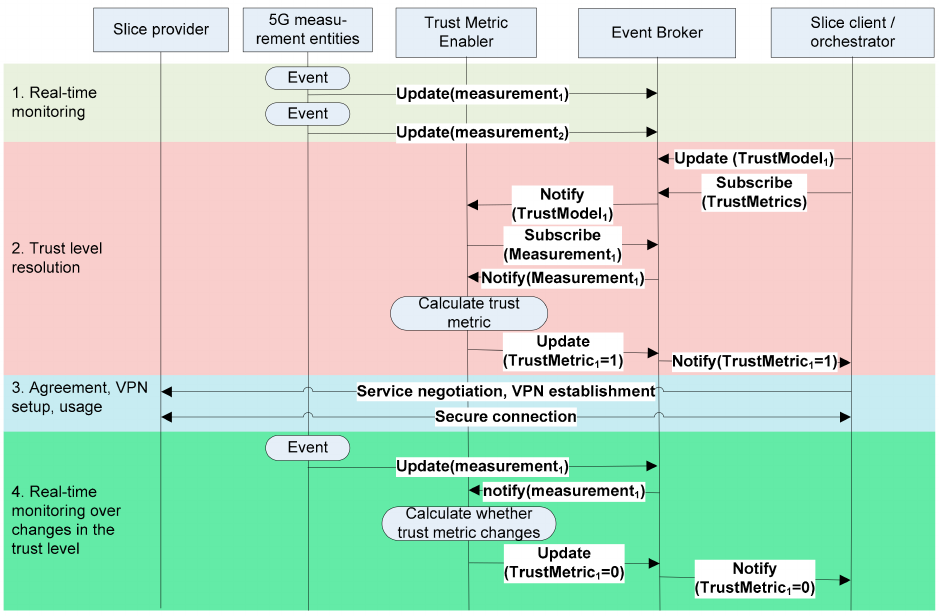
Figure 4. Trust Level Agreement messaging—The framework aggregates, filters, and brokers of security information between domains (updated from the Trust Metric Enabler’s open specification [37]). VPN: Virtual Private